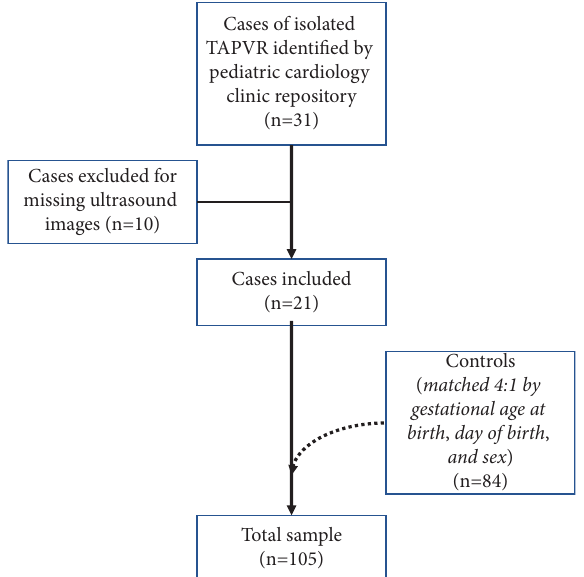
Figure 5: Flow diagram of study participants.